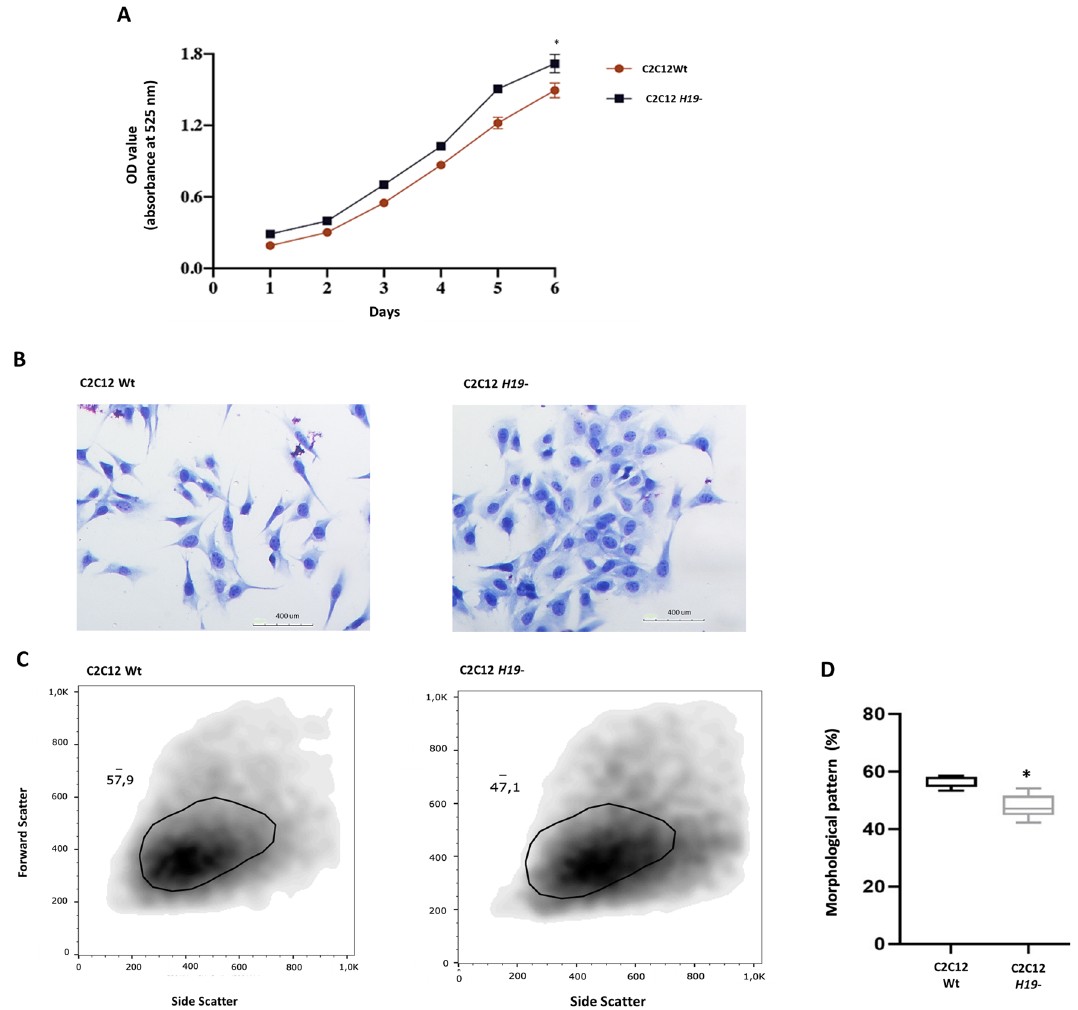
Figure 3. Cell proliferation assay and morphology. ( A ) MTT cell proliferation assay during six days of culture showing increased proliferation rate in H19 knockdown ( H19 -) cells (* p = 0.0025). ( B ) Myoblastic cell morphology was not altered in both C2C12 wild-type (Wt) and H19- cells and an increased number of cells in the field were observed (100 × Magnification). ( C ) Flow cytometry histograms showing increased cell size (forward scatter, FS) and cytoplasmatic granularity (side scatter, SS) in the H19- cells. ( D ) Overlay of the FS and SS showing the percentage of altered morphological patterns in C2C12 H19 - cells (* p =